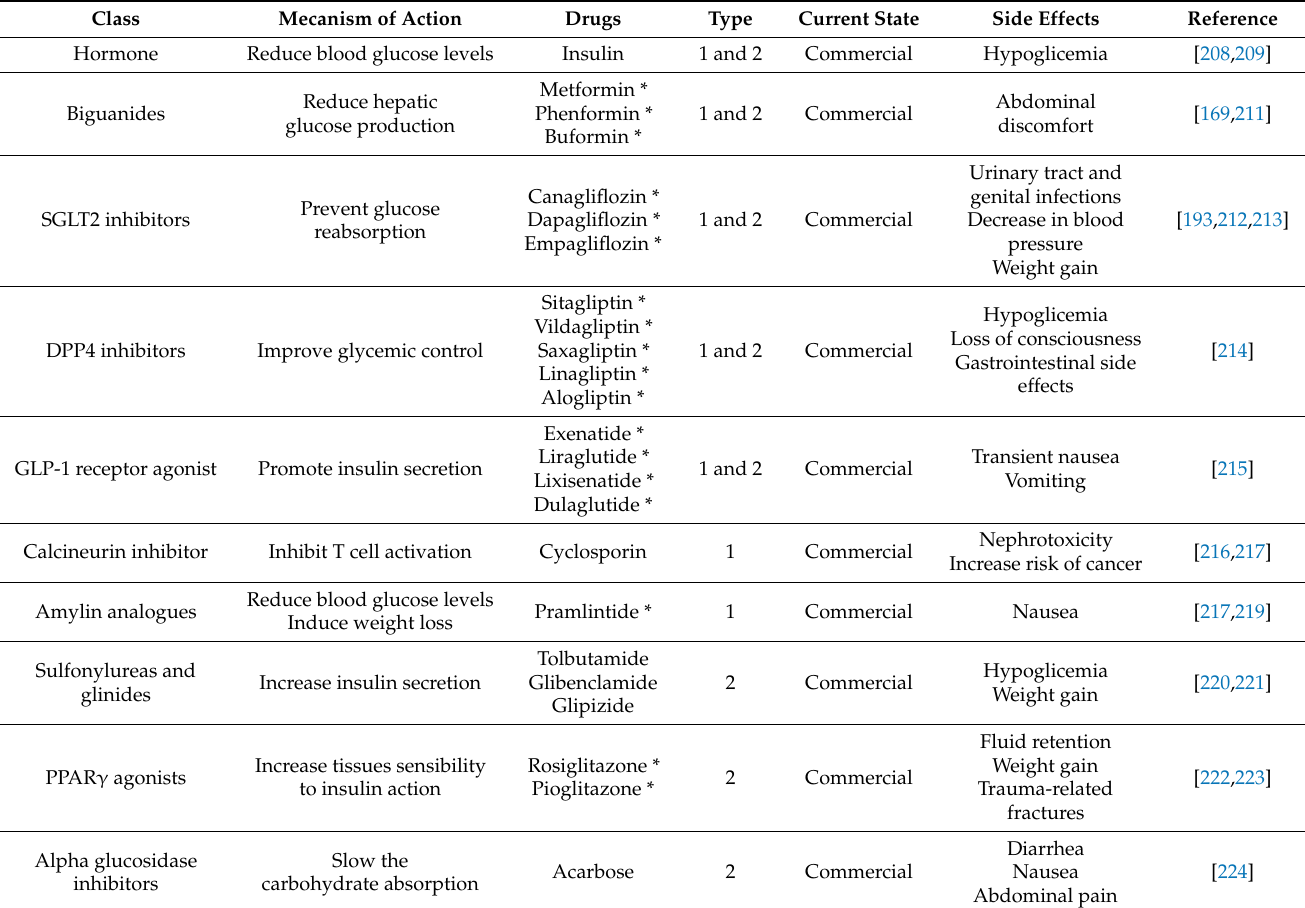
Table 2. Pharmacological treatments for diabetes mellitus. The compounds are divided into class, mechanism of action, drugs examples, current state of application and its side